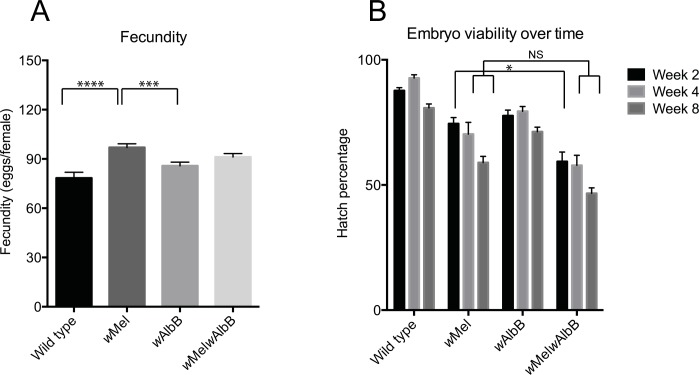
Fecundity and fertility of Wolbachia-infected Ae. aegypti.(A) Fecundity of Wolbachia-infected and wild type females as determined by mean egg production from individual female mosquitoes. Statistical significant differences between all data sets were determined using a Kruskal-Wallis test with Dunn’s multiple comparisons test. Significant differences are indicated by **** (p < 0.0001) or *** (p < 0.001) and standard error of the mean is indicated. Non-significant differences are not indicated. (B) Mean hatch rate of Wolbachia-infected and wild type females as determined by percentage of eggs hatching over time. Statistical differences between all data sets were determined using a two-way ANOVA with Tukey’s multiple comparisons test. For simplicity, only the comparison between wMel (current release strain) and wMelwAlbB is shown in the figure. A small but significant difference between the hatch rates for wMel and wMelwAlbB was observed after two weeks (*, p = 0.0159), however, no significant differences could be found at the 4 and 8 week time points. All experiments were conducted using mosquitoes from G8 of the superinfected line and standard error of the mean is indicated.